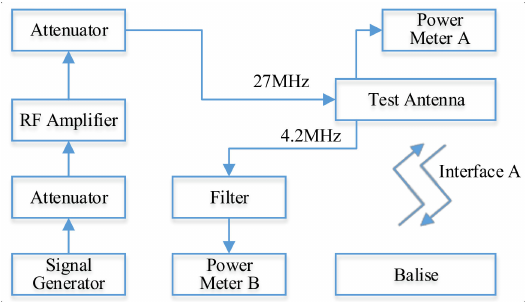
Figure 7. Balise input–output characteristics test